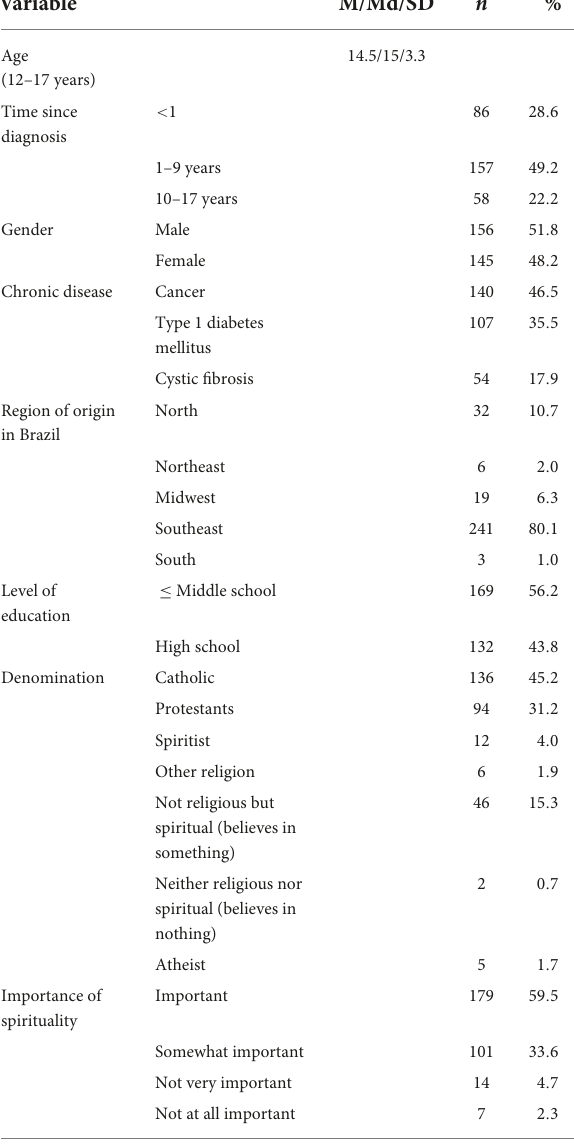
TABLE 1 Characteristics of adolescents ( N =